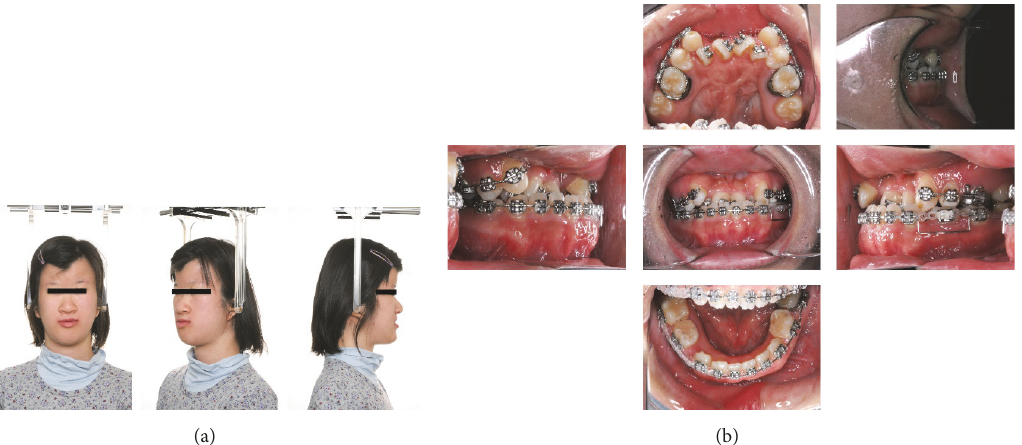
Figure 5: Facial (a) and oral (b) photographs before maxillary anterior segmental distraction osteogenesis (18 years and 6 months).